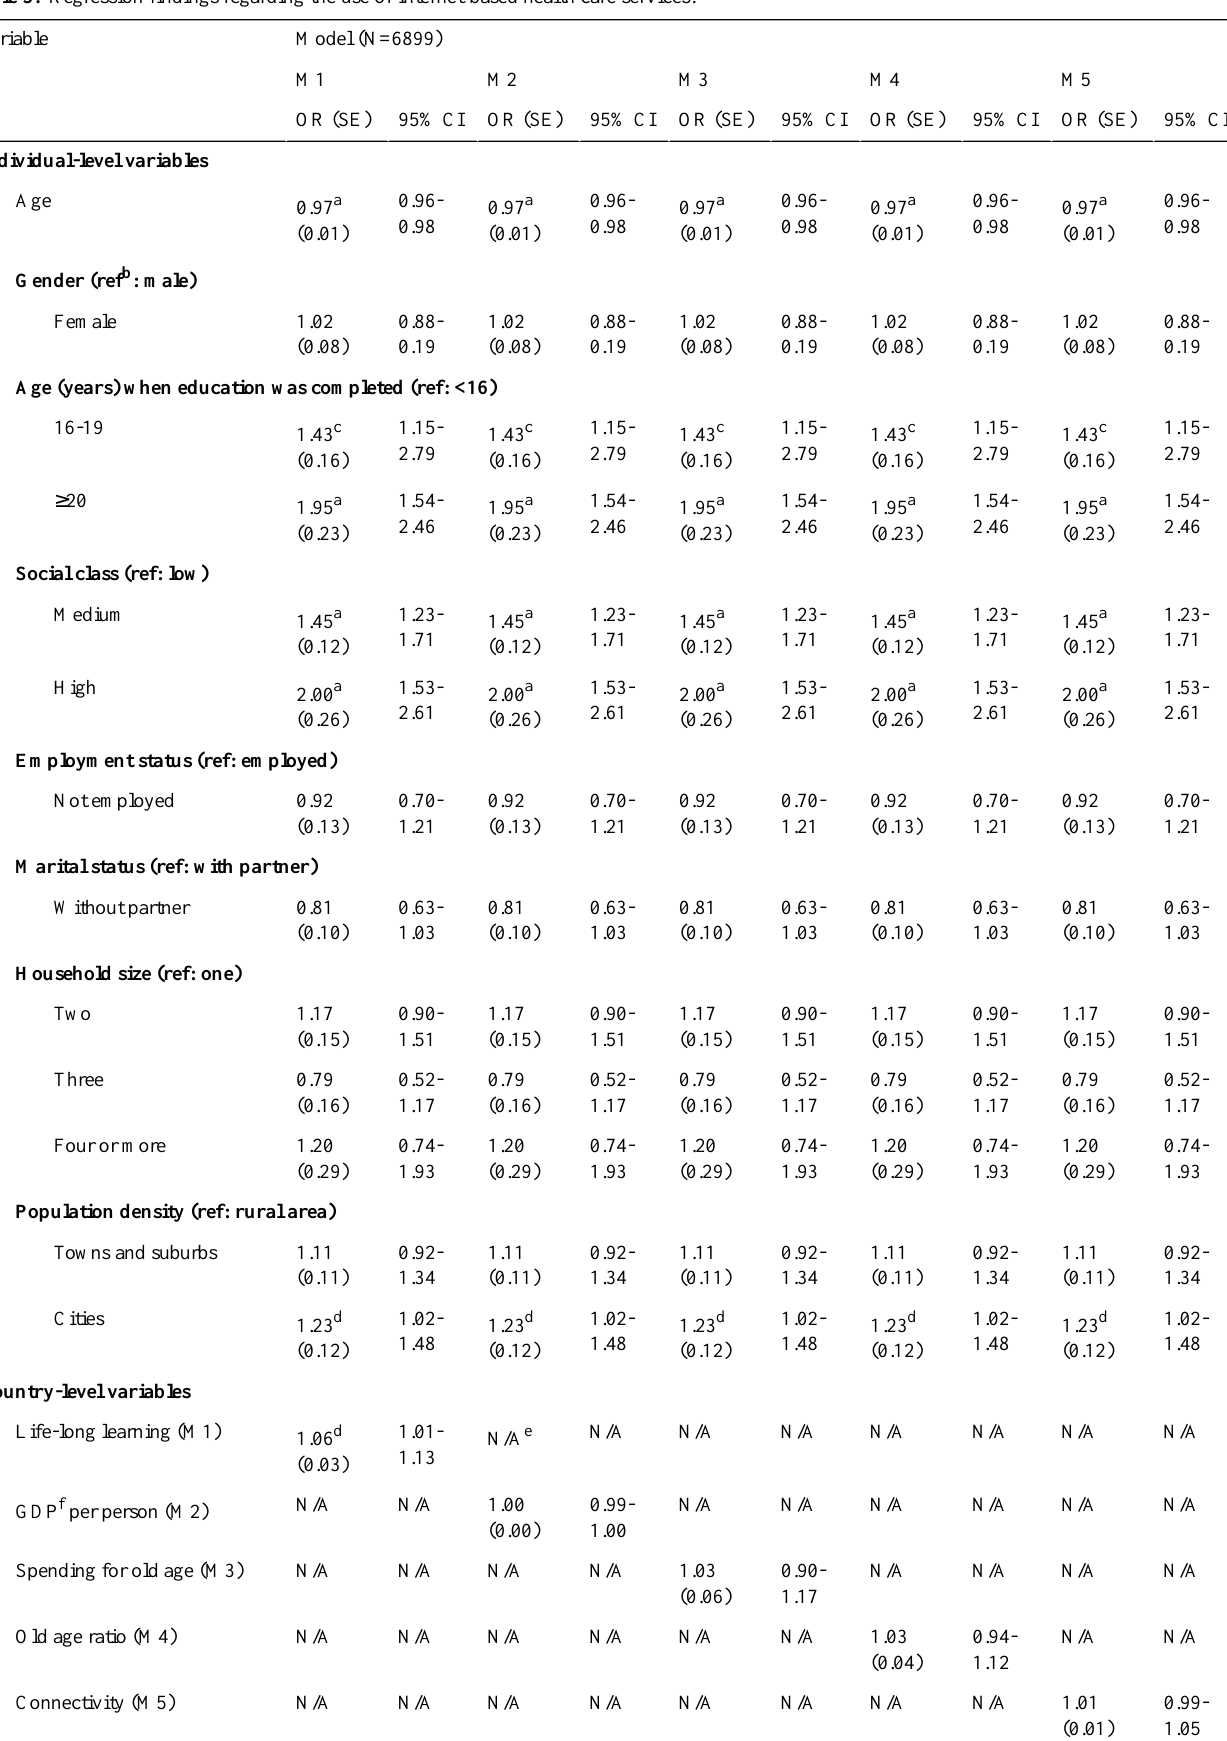
Table 3. Regression findings regarding the use of internet-based health care services. Model